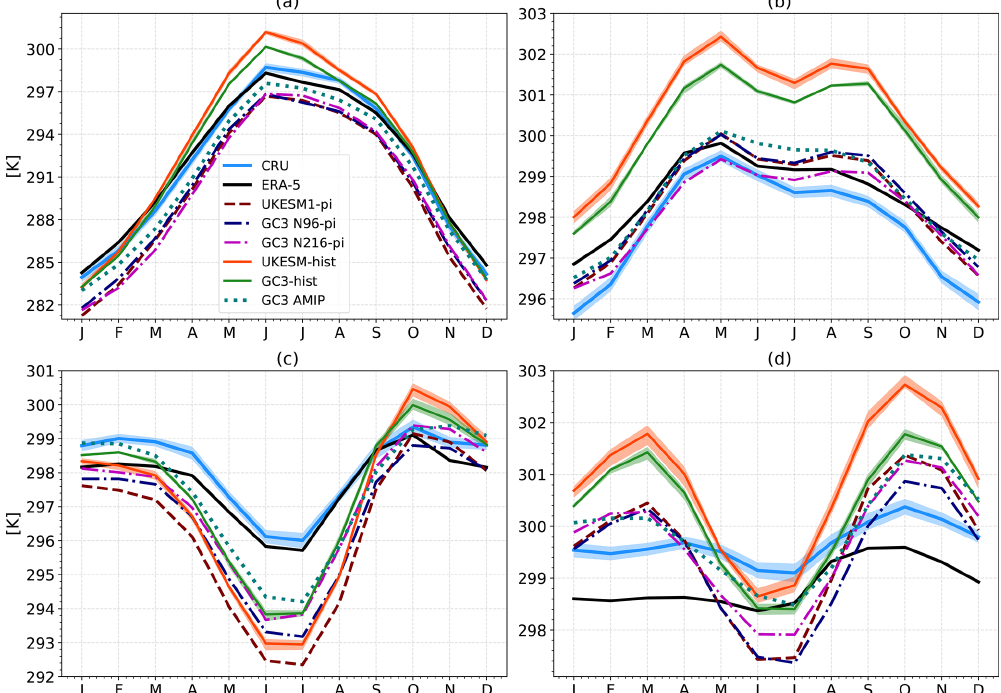
Figure 3. Monthly-mean temperature in the (a) North American monsoon (19–35 ◦ N, 110–103 ◦ W), (b) the midsummer drought (11–19 ◦ N, dataset represents the observational uncertainties, and for the historical simulations the shading is the ensemble spread. The regions for this plot are shown in Fig. 1a.